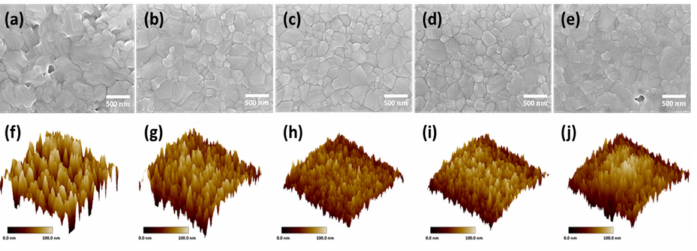
Figure 1. SEM and AFM of perovskite films’ surface structures. The films were prepared with different delay-annealing times: ( a , f ) 0 min; ( b , g ) 30 min; ( c , h ) 60 min; ( d , i ) 90 min; ( e , j ) 120 min.